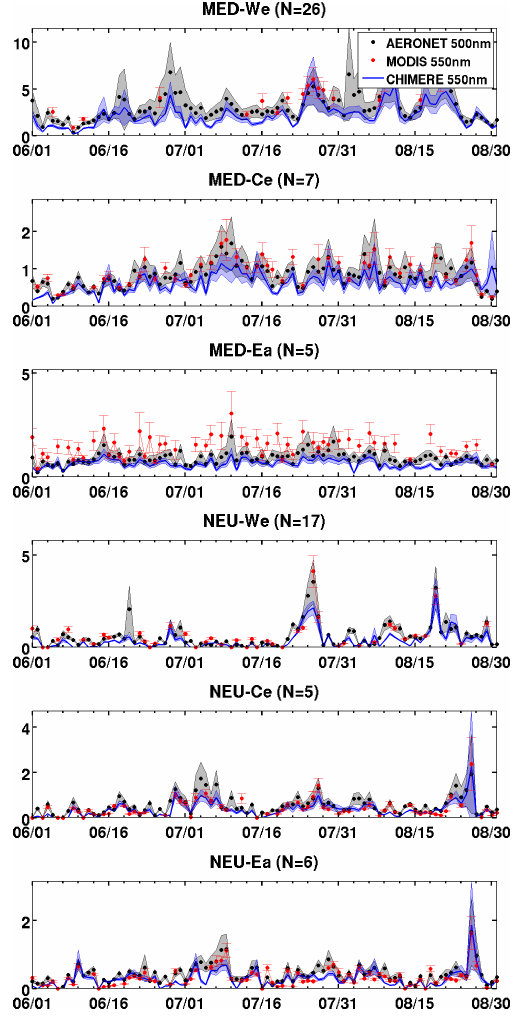
Figure 7. Temporal evolution of the daily mean AOD observed at 500nm at the AERONET stations (black dots) and at 550nm from MODIS Aerosol Products (red dots), in addition to simulated AOD at 550nm by the CHIMERE model (blue line) during the summer of 2012. The standard deviation among the stations is indicated in grey and blue shaded area for AERONET and CHIMERE, respectively, and with red bars for MODIS. Number of stations in each region is indicated by the value of N